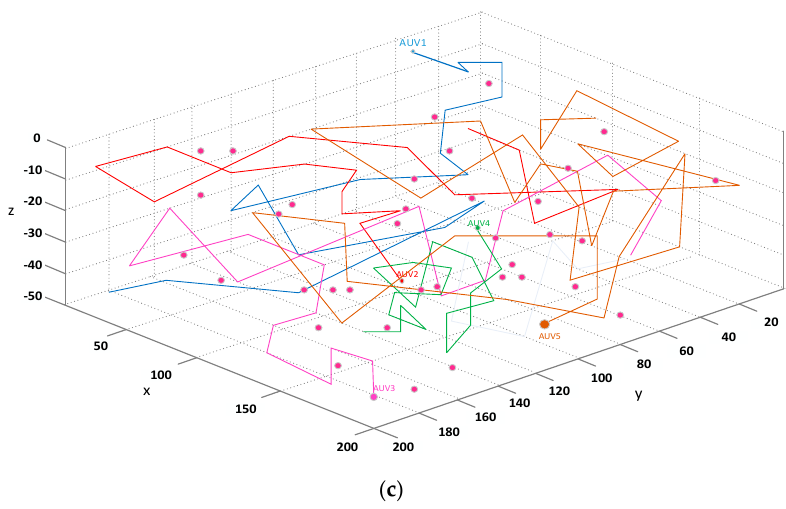
Figure 9. The cost of three search algorithms. ( a ) Adaptive prediction search algorithm; ( b ) Lawn-mowing algorithm; ( c ) Random algorithm.